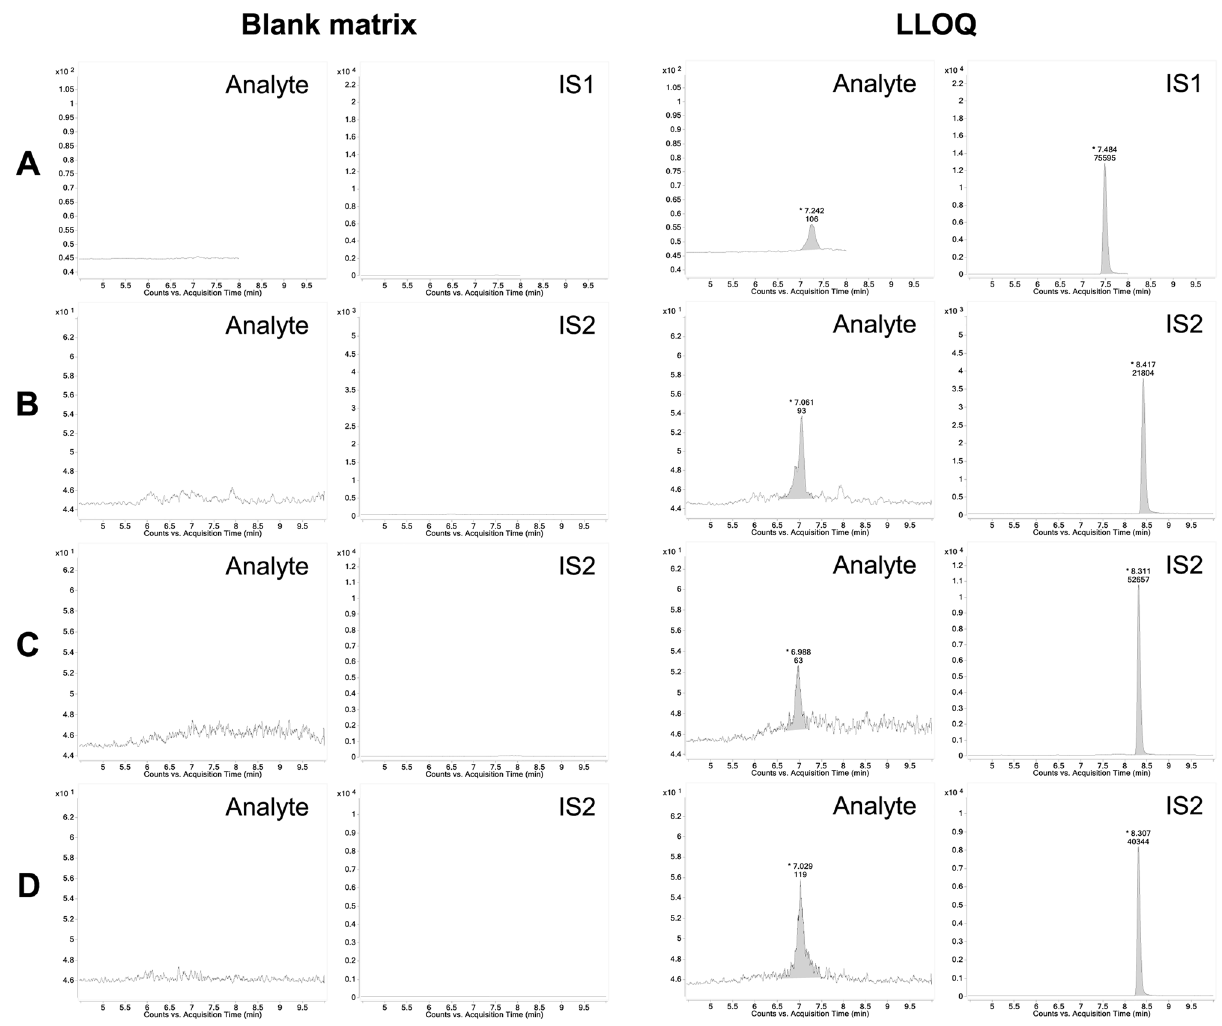
Figure 2. Representative MRM chromatograms of 175 Lu-DOTA-PSMA-GUL (analyte) and internal standard (IS) obtained from blank matrix (left) and blank matrix spiked with 175 Lu-DOTA-PSMA-GUL at LLOQ and IS (right) for plasma ( A ), urine ( B ), feces ( C ), and prostate ( D